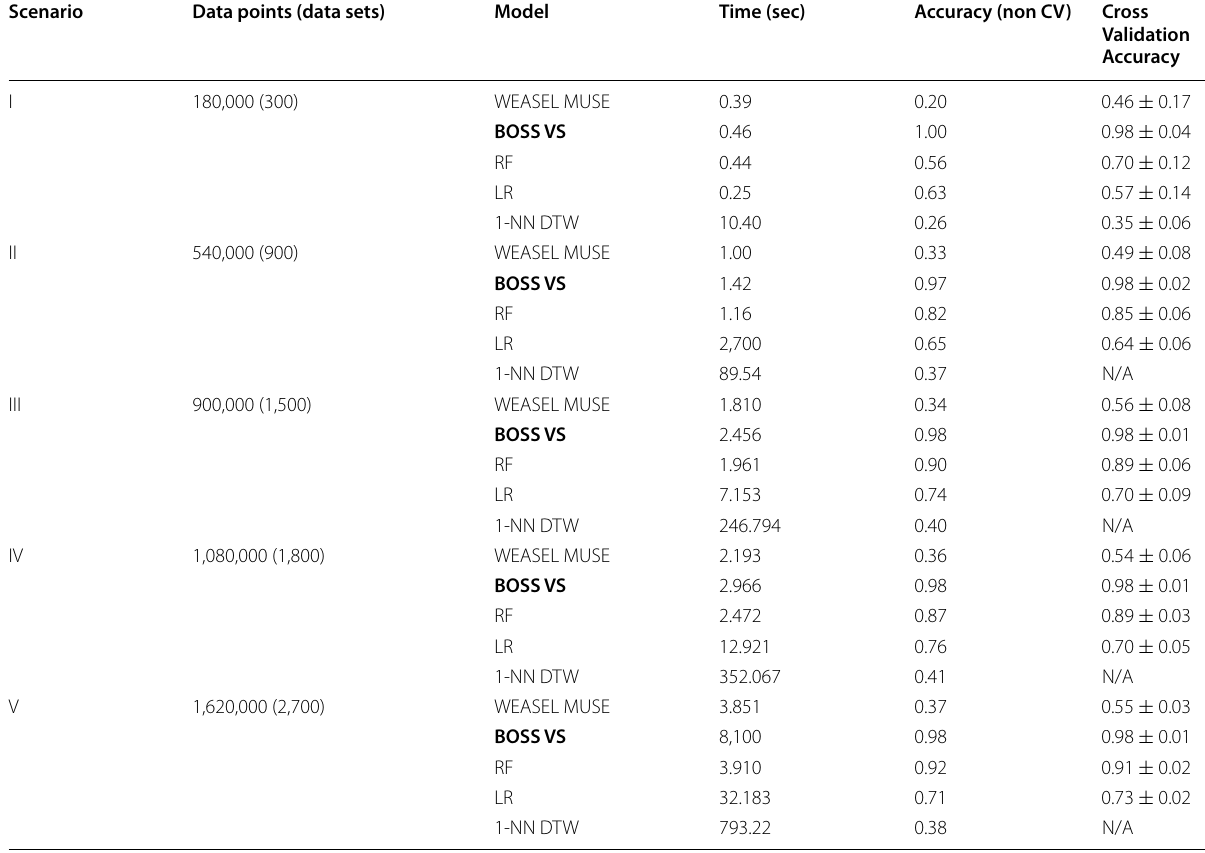
Table 6 Comparison of performance of five models according to five scenarios: The number of data points is increased from 180k up to 1.6 Million. As for Fog computing facility: Intel Core i3‑8100 CPU 3.60GHz at 4GB memory, and the OS is Ubuntu 20.04.1 LTS. BOSS VS model shows excellent scalability while keeping the highest accuracy among the other models. N/A denotes that simulation data is unavailable due to computation crashes caused by hardware limitations in this Fog computing facility. The 10‑fold cross‑validation accuracy is shown in the 95% confidence level